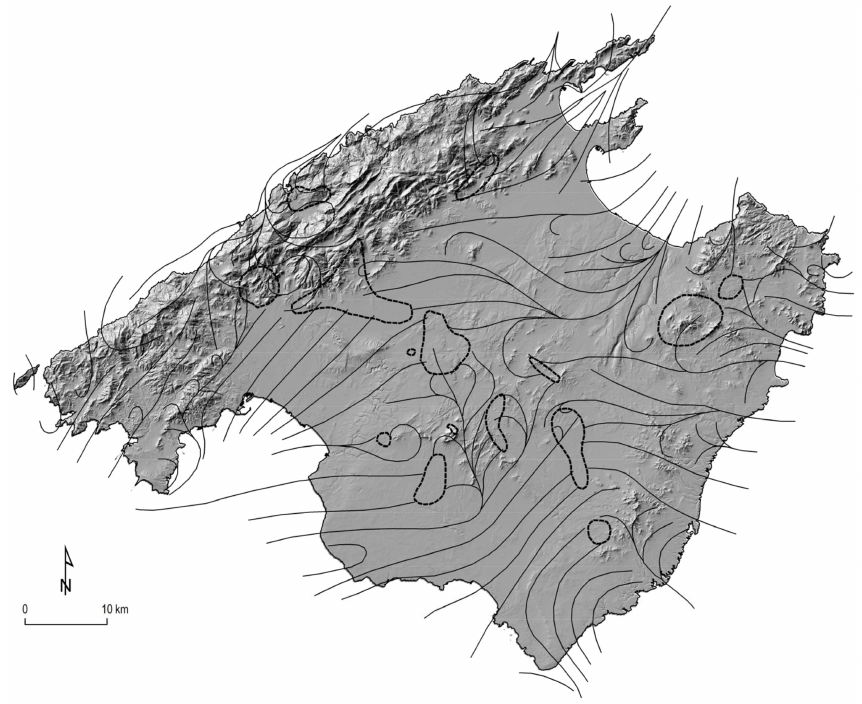
Figure 2. Wind (sea-breeze) current lines around the isle of Mallorca (continuous line) and conver- gence areas (closed dashed lines). Own redrafting based on data from Jans á and Jaume [34], drawn using a digital elevation model